Question: What visual encoding does this figure use to show its data?
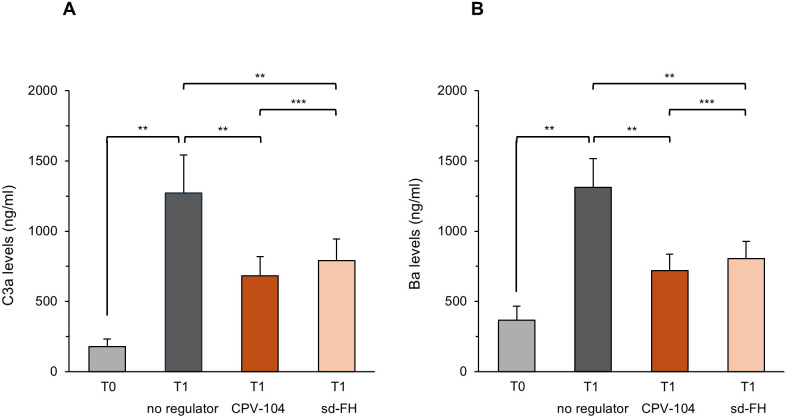
Answer: bar